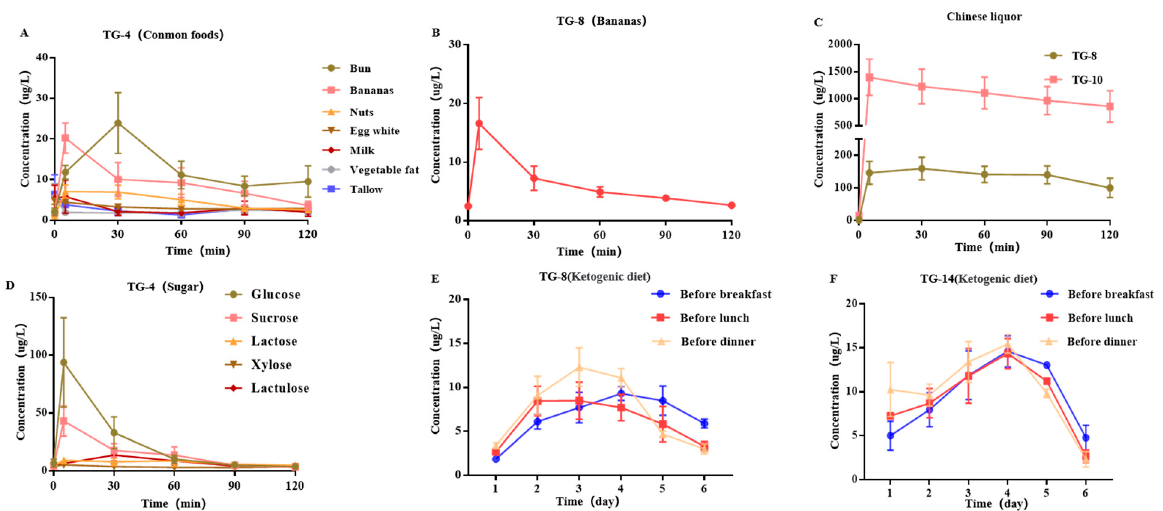
Figure 3. Changes in VOC concentration in exhalation after different diets. ( A – C ). Changes in car- bonyl VOCs’ concentration in human exhaled breath after eating some common foods. ( D ) Changes in the concentration of TG-4 in the exhaled breath after drinking different sugar solutions ( E , F ). Values and error bars represent mean ± SE.